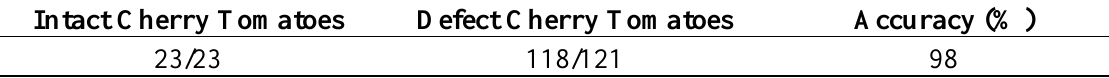
Table 1. Classification